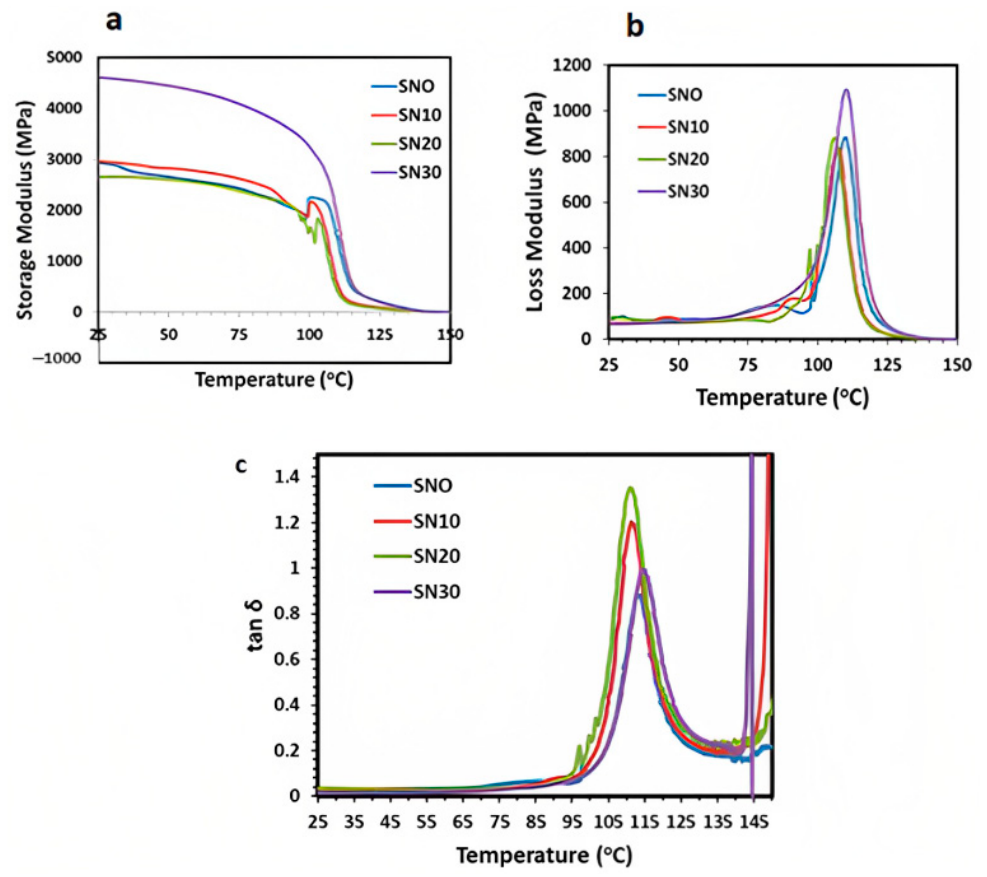
Figure 10. DMA curves of pristine PS and PS/m-BN composites ( a ) storage modulus (E ′ ), ( b ) loss modulus (E ′′ ), and ( c ) damping factor (tan δ ).